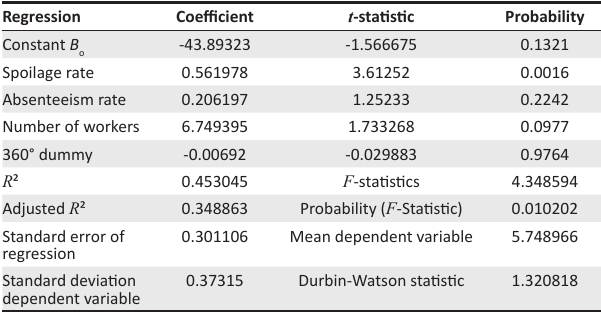
TABLE 2: Labour productivity results relating to spoilage and absenteeism rates, number of workers involved in production, and post 360-degree dummy. Regression